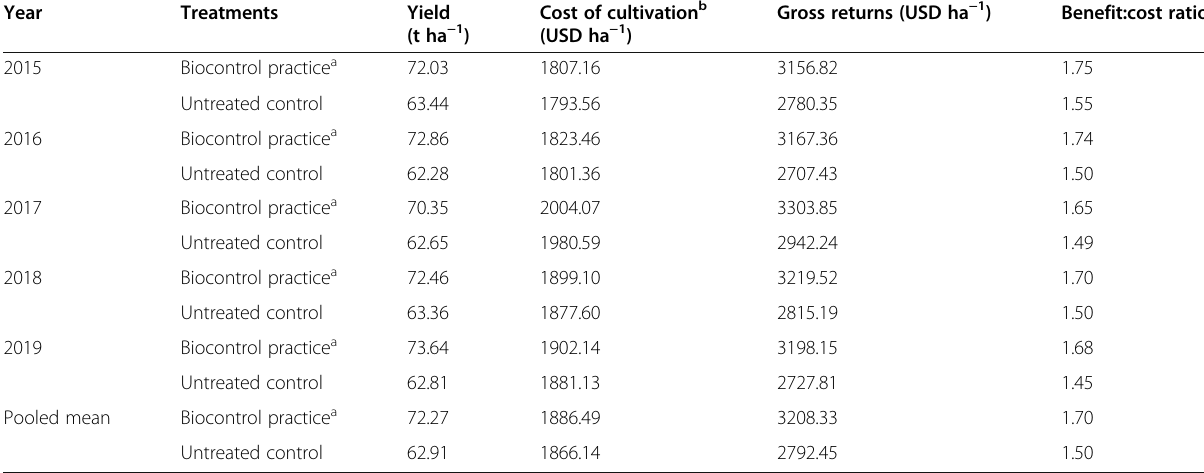
Table 5 Cost of cultivation and economics returns from various treatments in the management of C.